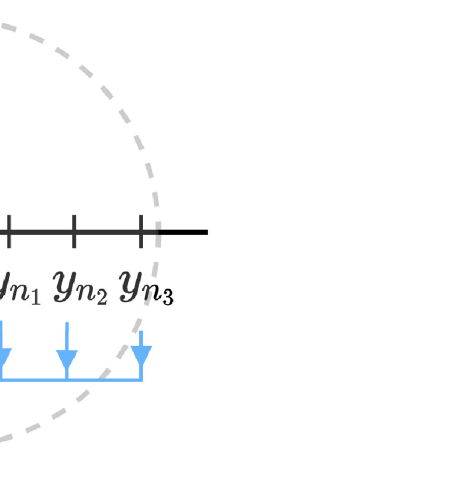
4.3.3 Time-E K NN (TEKNN) imputation. The idea behind this imputation approach is to use the E K NN regression model to predict the missing label values based on the complete